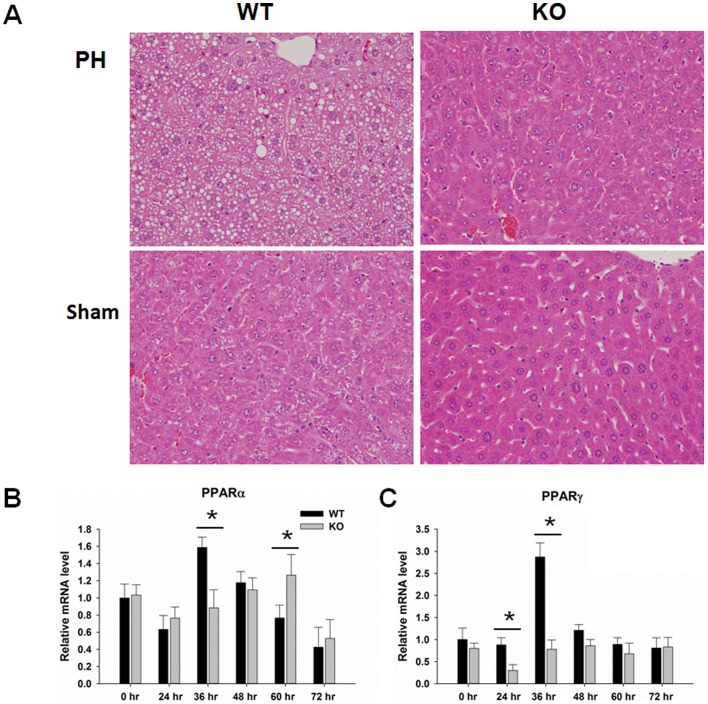
Lipid accumulation in wild-type (WT) and PPARβ-null (KO) mice after PH.(A) Hematoxylin and eosin staining shows lipid accumulation in WT mice, but not in KO mice, 36 hr after PH. Sham tissue used as negative control. (B) Hepatic gene expression levels of (B) PPARα and (C) PPARγ in WT and KO mice over a time course from 0 to 72 hours after PH (n = 3). Means ± SD are graphed. * p<0.05.